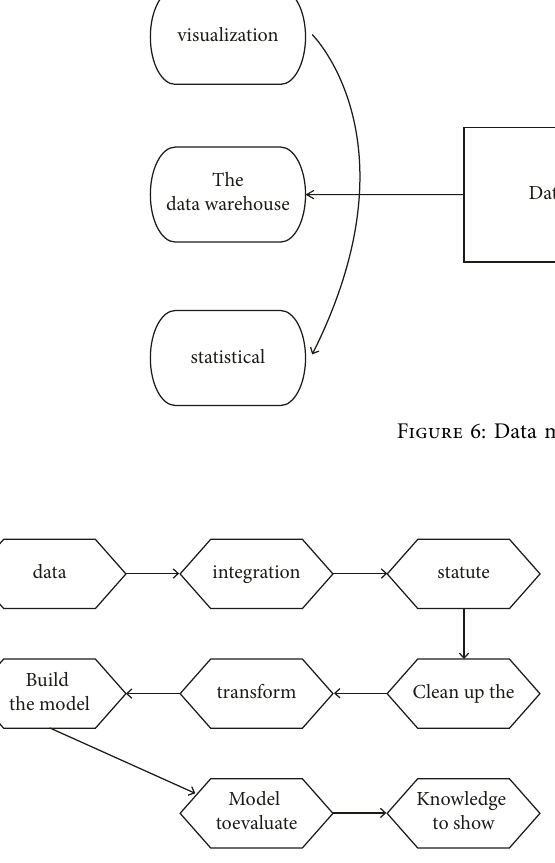
Figure 7: Data mining